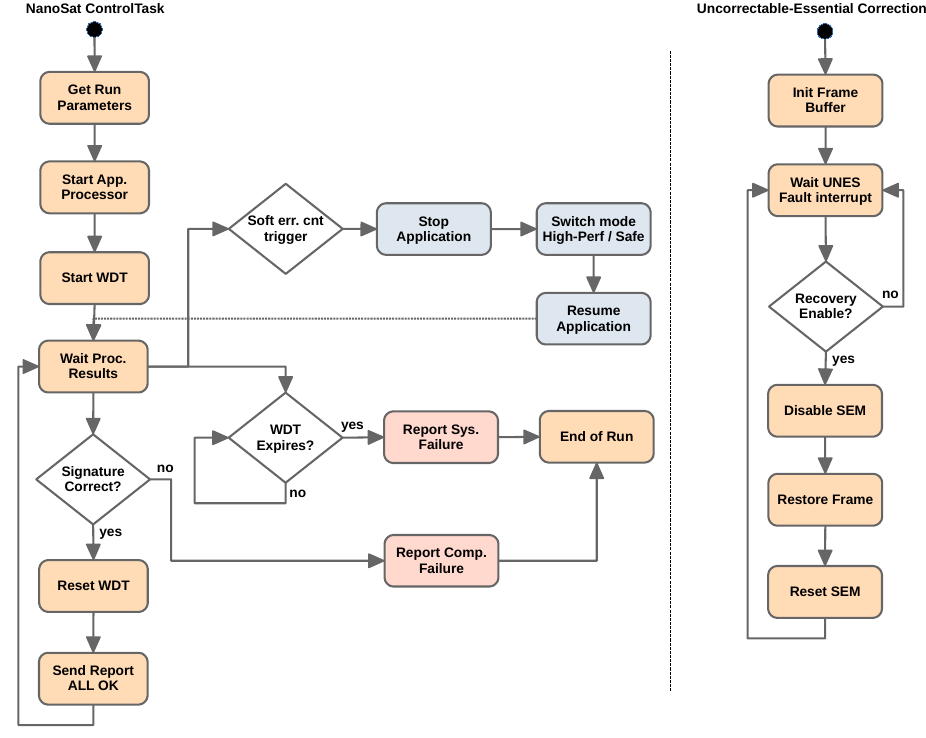
Figure 6. Monitoring